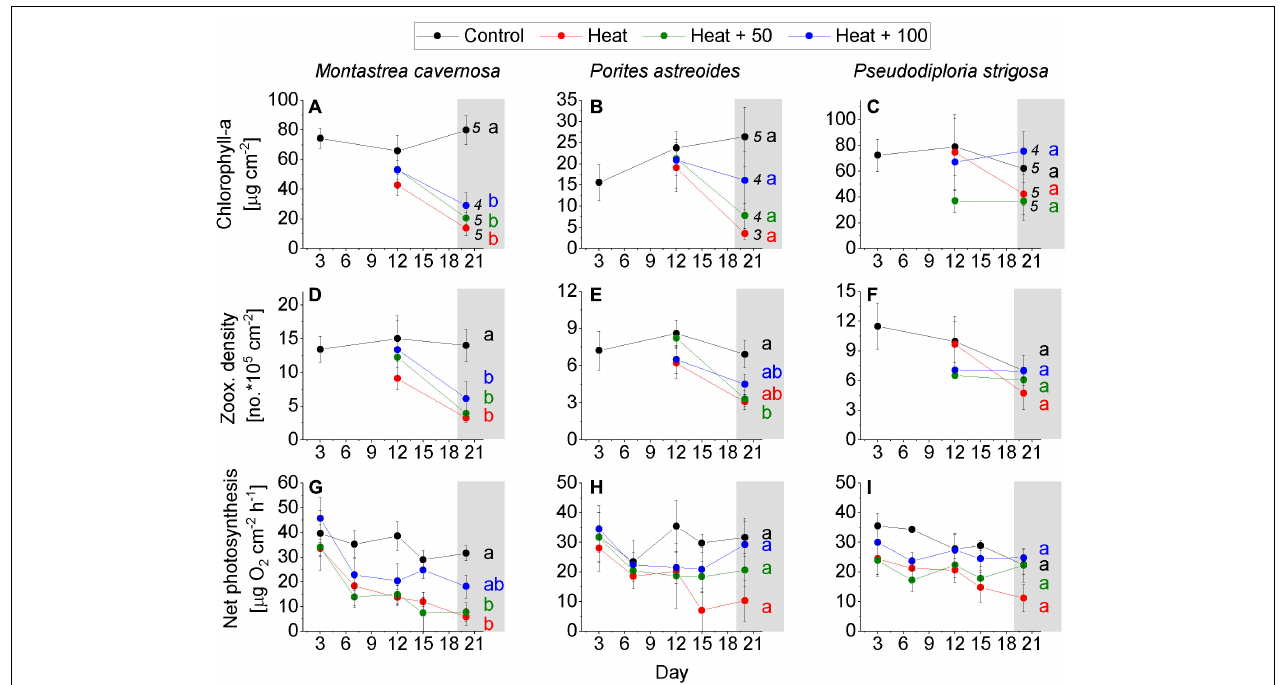
FIGURE 3 | Coral response over the experimental period. (A–C) Chlorophyll- a concentration of the control corals on day 3 and of corals of all treatments on day 12 and 20. (D–F) Zooxanthellae density of the control corals on day 3 and of the corals of all treatments on day 12 and 20. (G–I) Net photosynthesis measured on day 3, 6, 9, 12, 15, 18, and 20 on coral of all treatments. Mean ± SE. Numbers behind data points of day 20 = number of replicates on day 20 (initial number of replicates = 5). Letters indicate statistical results with equal letters indicating p > 0.05 between treatments on day 20 and different letters indicating < 0.05 (one-way ANOVA, Tukey HSD post hoc